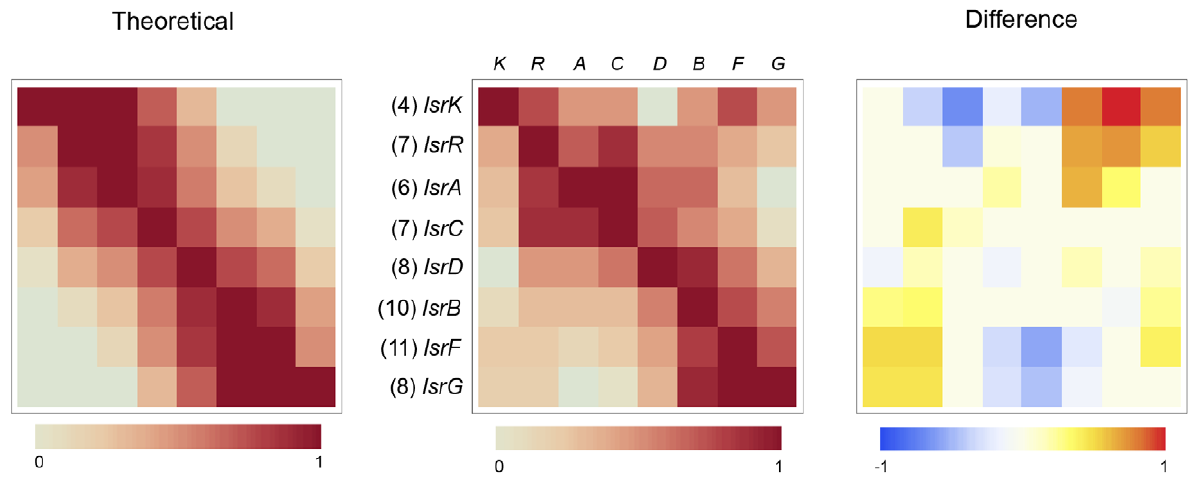
Figure 8. Coincidence matrix for E.coli Lsr system LMNAST stringent search hits. This coincidence matrix depicts the subset of hits with a mean element homology . 0.3 and also containing 4–6 gene characters. This subset was chosen for its intermediate degree of homology to the query Lsr system. LsrF and lsrG characters were found to be overrepresented among these hits coincident to hits also containing lsrR and l srK characters.